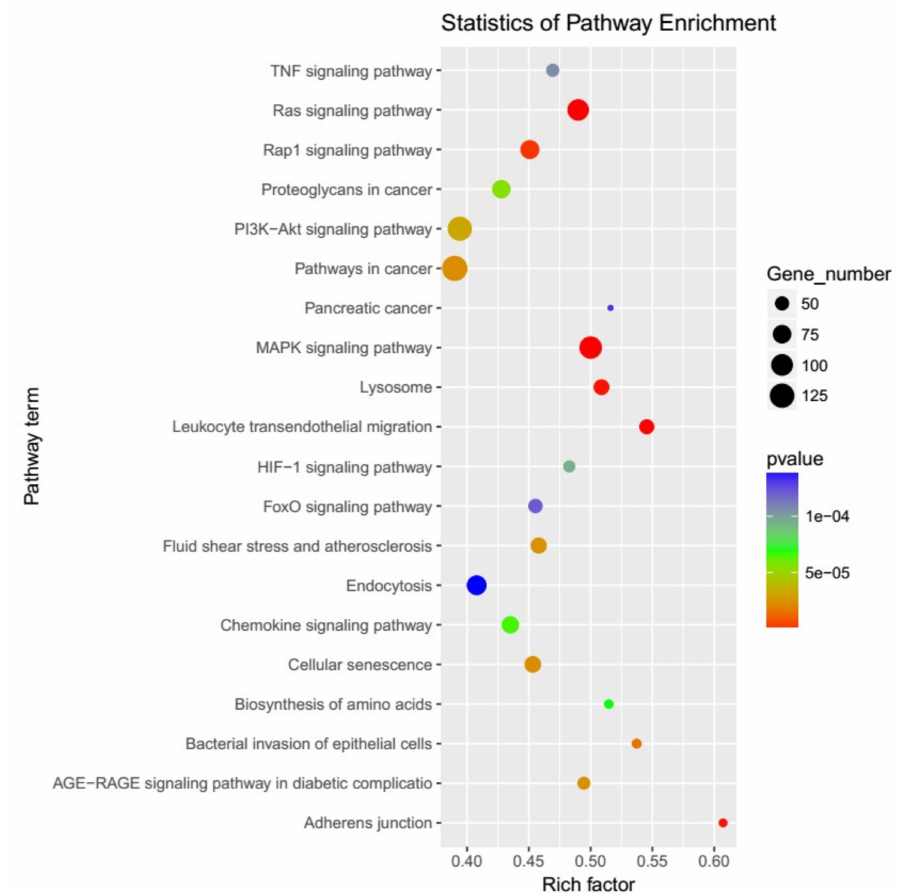
Figure 2. KEGG analysis of the predicted target genes, showing the top 20 prominent KEGG